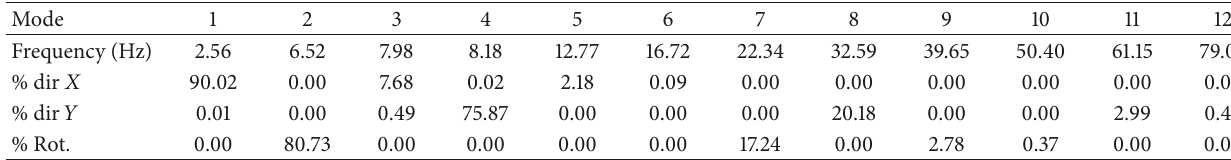
Table 9: Structure A FE model frequencies and excited masses.